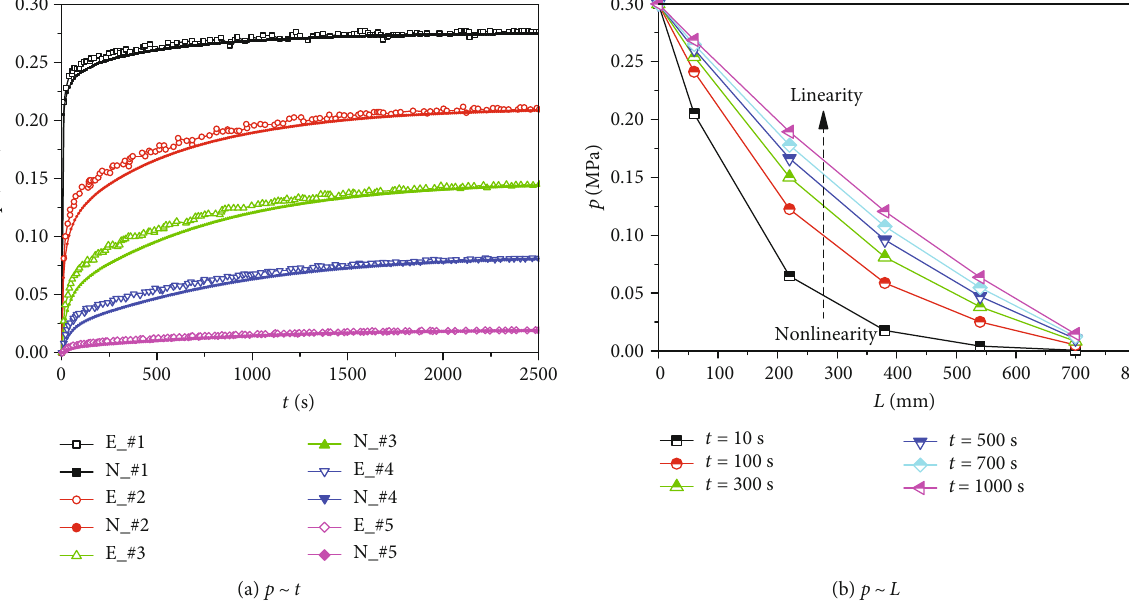
Figure 7: Experimental and numerical evolution characteristics of p